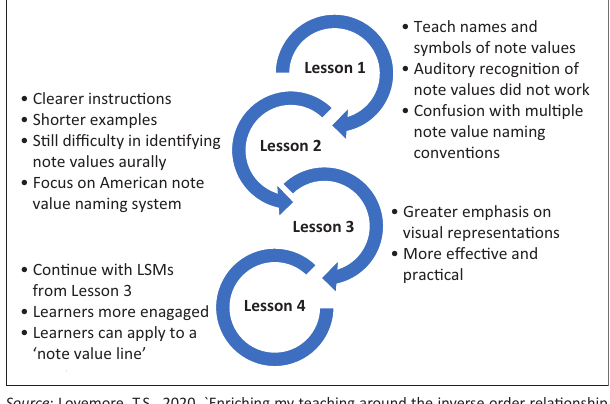
FIGURE 3: Representation of the cycles of reflection, from the first author’s reflective journal, exemplified through Lessons